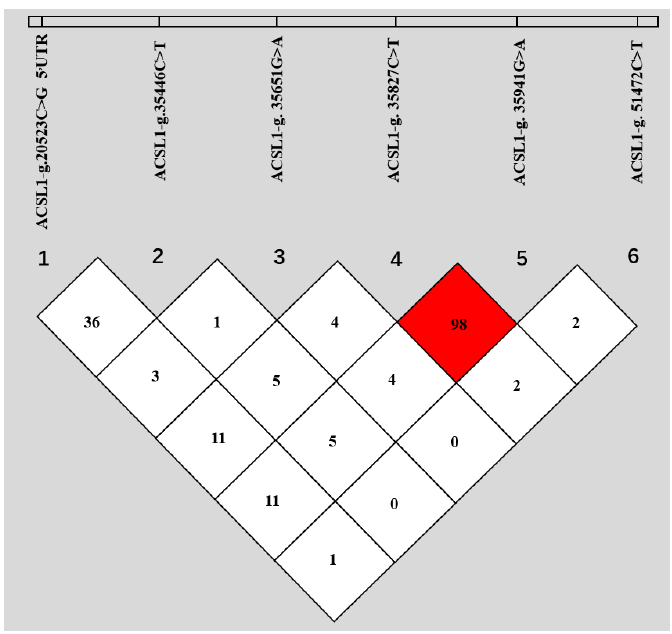
Figure 1. Long-chain acyl-CoA synthetase 1 gene ( ACSL1 ) with the localization of the six identified single nucleotide polymorphisms (SNPs).